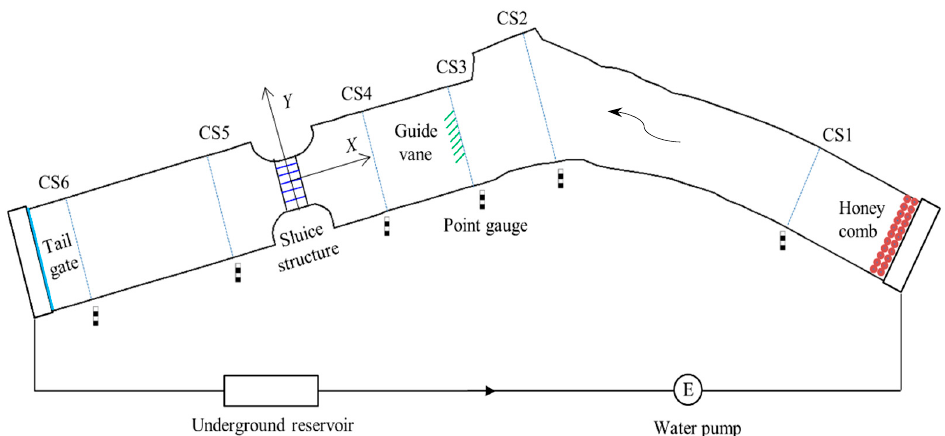
Figure 7 . Laboratory model of the sluice with six bulkhead gates constructed in scale λ = 1:40, with a 30 m length measured along the river centerline and a 4 m width in cross-section. ( a ) View from the right bank; ( b ) sluice structure, looking downstream.